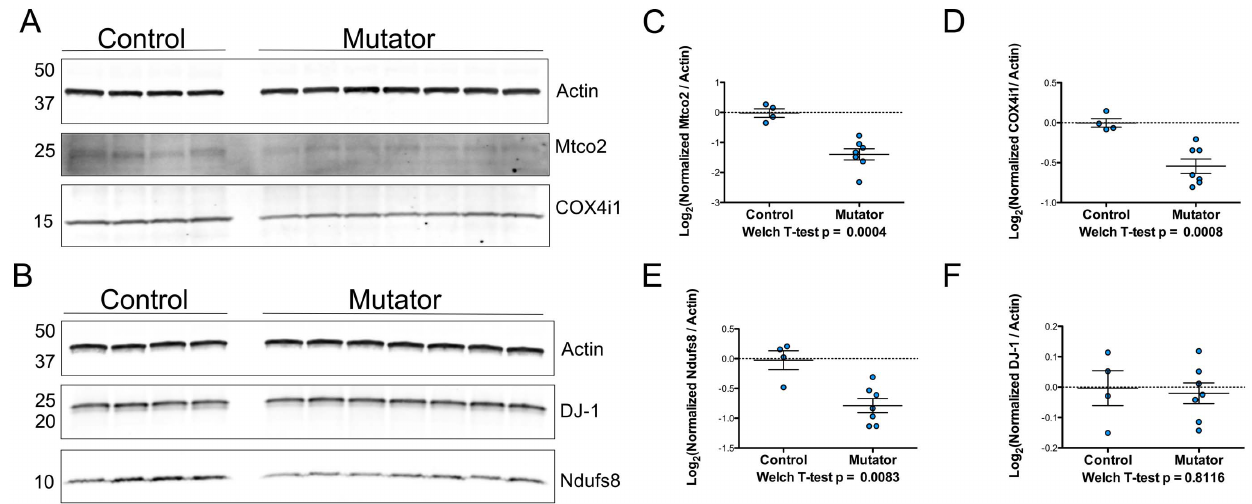
Figure 3. Western blot analysis of cerebellar proteins of interest. A–B) Actin, Mtco2, COX4i1, Ndufs8, and DJ-1 protein levels were measured in cerebellar protein extracts from the mice used in the iTRAQ experiment. C–F) Quantitation of Western blots (n=4 control, n=7 mutator). Data was normalized to the mean of the controls and log 2 transformed. Welch T-tests were used to compare groups and the p-values are listed beneath the graphs. Actin was used as a loading control to normalize data.